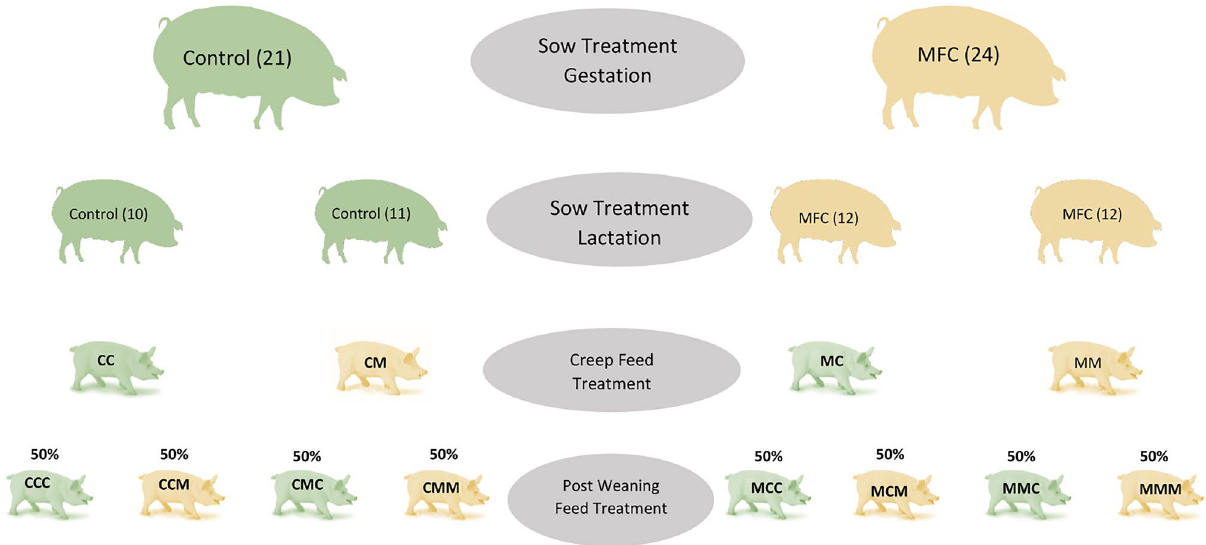
Figure 8. Schematic diagram of sow and piglet feeding plan. MFC Sows fed micro-fibrillated cellulose; MM sow MFC, piglets fed MFC creep feed; MC sow MFC, piglets fed control creep feed; CM sow control, piglets fed MFC creep feed; and CC sow control, piglets fed control creep feed. MMM sow MFC, piglets fed MFC creep feed, post-weaning piglets MFC feed; MMC sow MFC, piglets fed MFC creep feed, post-weaning piglets control feed; MCM sow MFC, piglets fed control creep feed, post-weaning MFC feed; MCC sow MFC, piglets fed control creep feed, post-weaning control feed; CMM sow control feed, piglets fed MFC creep feed, piglets